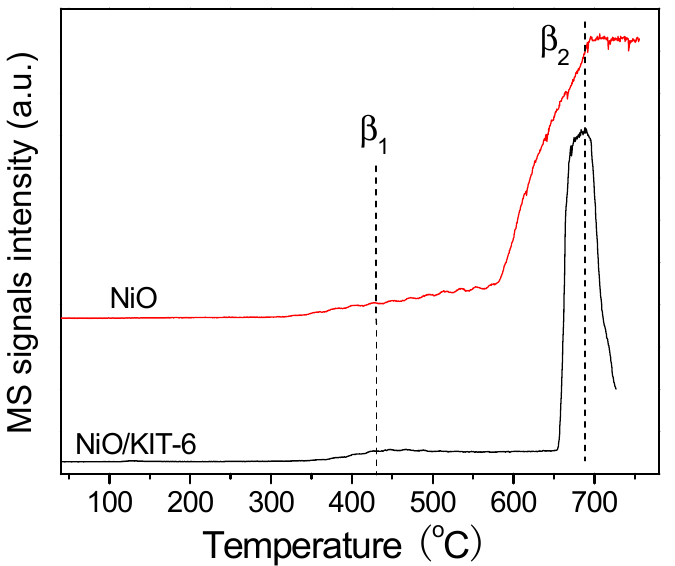
Figure 6. MS signals of CO 2 ( m / z = 44) in the CH 4 -TPSR of NiO and 10 wt% NiO/ KIT-6 catalysts. The effect of the support is also investigated. The observed activities of the 10 wt% NiO/KIT-6, 10 wt% NiO/SBA-15, 10 wt% NiO/MCF and 10 wt% NiO/SiO 2 catalysts are shown in Figure 7. It was found that the catalytic activities of methane combustion with NiO-based catalysts decrease in the following order: NiO/KIT-6 > NiO/ SBA-15 > NiO/MCF ≈ NiO/SiO 2 . The BET surface areas of KIT-6, SBA-15, MCF and SiO 2 are 708, 520, 562 and 387 m 2 · g − 1 , respectively. Therefore, the remarkable enhancement in activity of NiO/KIT-6 compared to NiO/SBA-15 and NiO/SiO 2 can be attributed to its 3D pore connectivity, as well as its large surface area and pore volume [38]. Though MCF also has 3D mesopores, the large pore size of MCF (15/30 nm) cannot restrict the aggregation of NiO nanoparticles effectively when NiO nanoparticles are incorporated into the pore